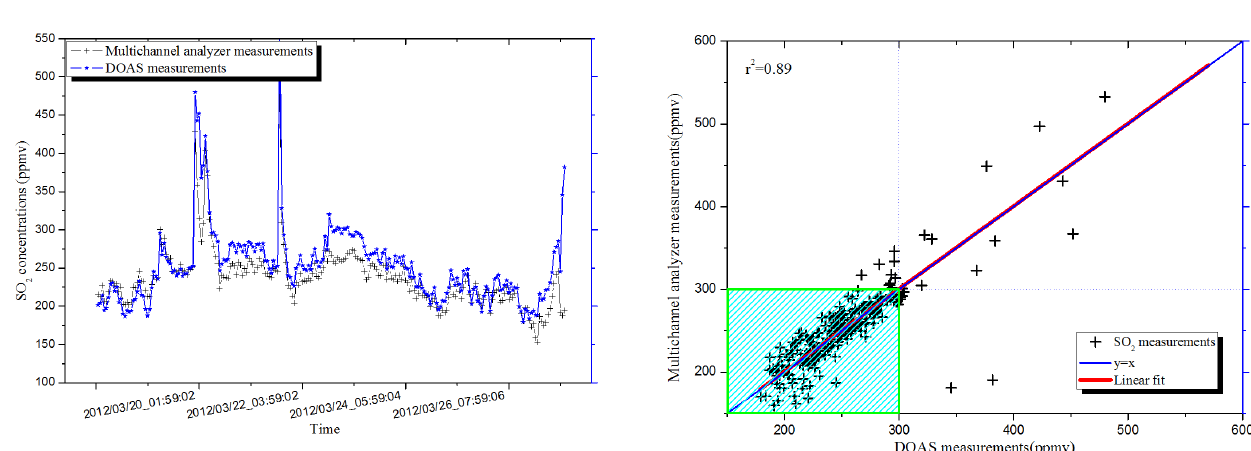
Figure 18. Correlation between the two analyzers for the time se- ries of Fig. 17. The green box again represents SO 2 concentrations appearing with the highest